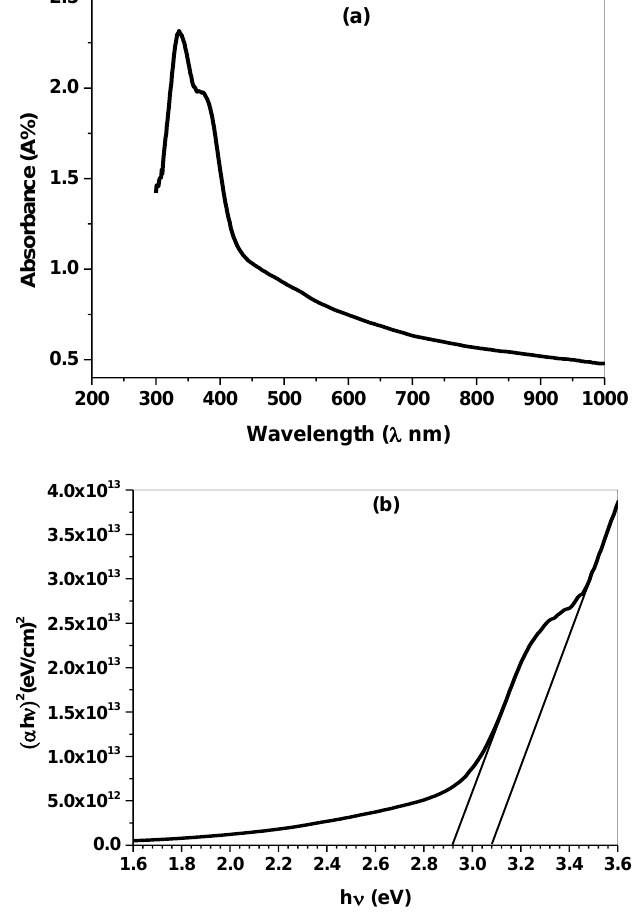
Figure 5. ( a ) Optical absorbance and ( b ) Energy gap of Co 3 O 4 thin film deposited on glass